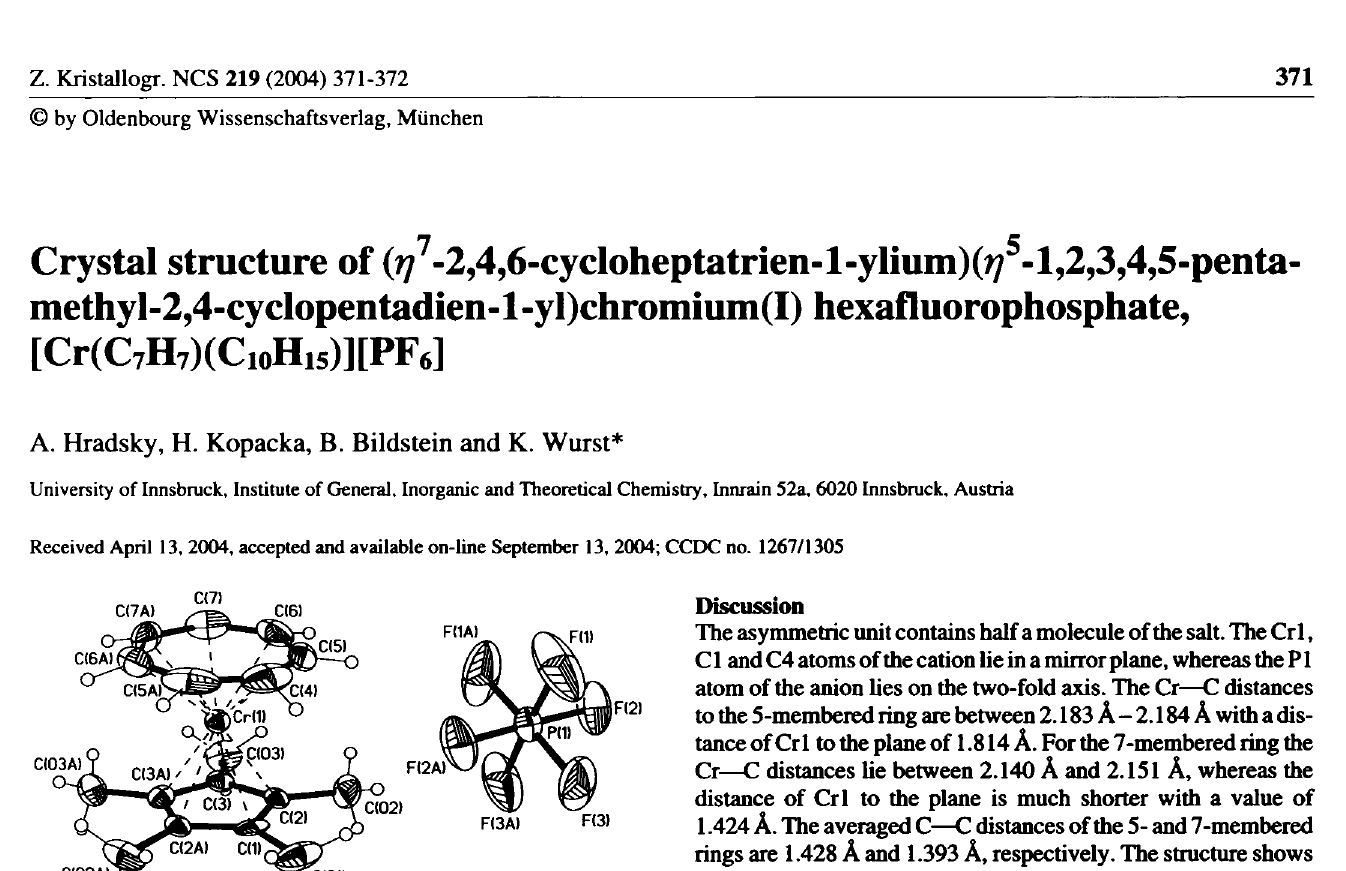
Table 1. Data collection and handling.